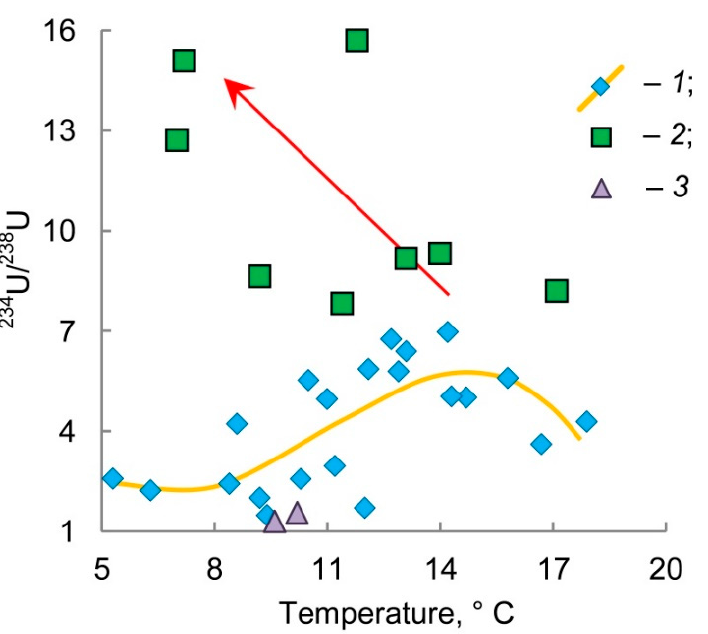
Figure 6. Relationship between the electrical conductivity and the hydraulic heads of groundwater in the Pre-Volga region: 1 —points where the hydraulic head does not deviate from the regional trend (equation of the approximation line is on the diagram); 2 —points where anomalies of the hydraulic heads and the uranium isotopic composition ( 234 U/ 238 U > 7.8) were found; and 3 —outliers (explanation in the text below).